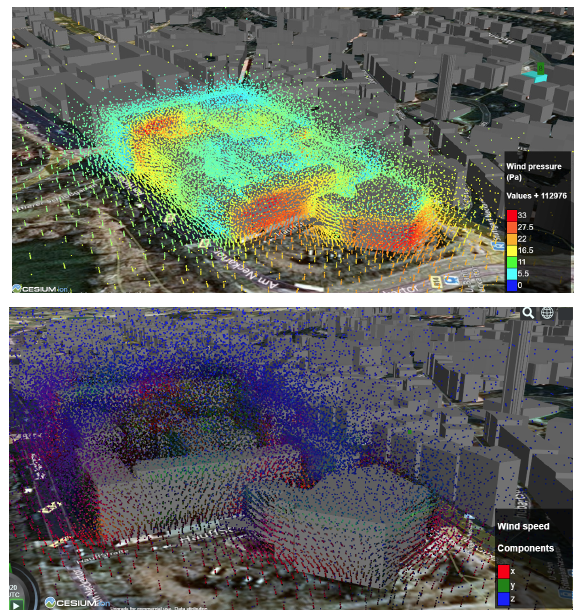
Figure 7. Visualization of a wind field and 3D buildings as 3DTiles (derived from CityGML). Top images shows visualization of wind pressure as points in different colours ranging from low (blue) to high (red). Bottom images shows wind speed encoded as RGB, where the R,G,B corresponds to components of wind speed in x,y,z,